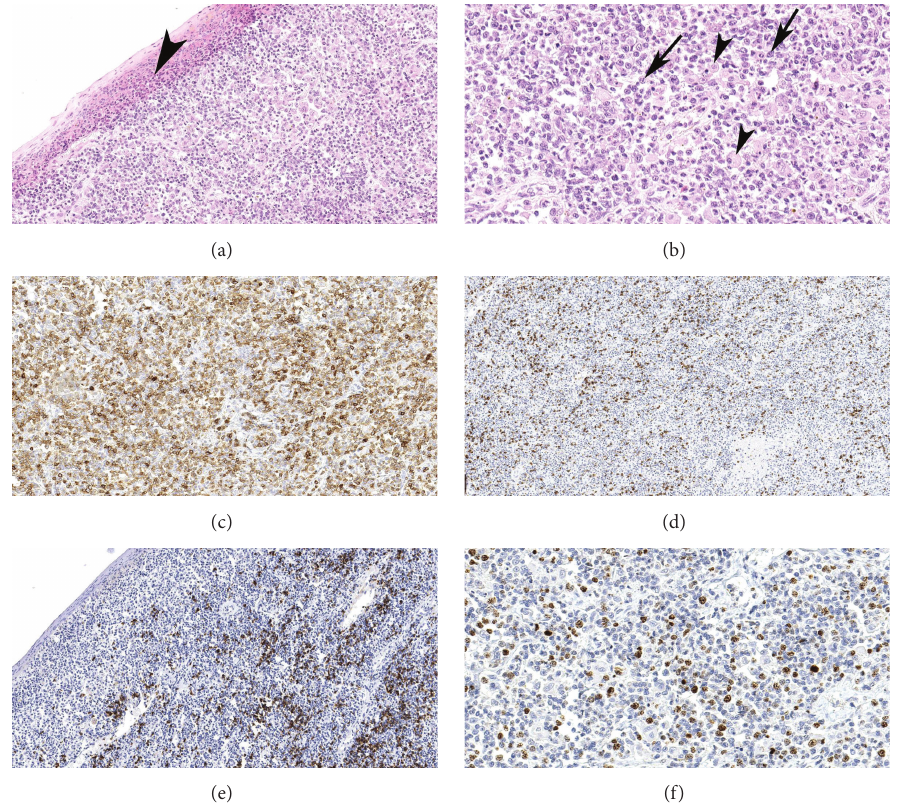
Figure 2: Histopathological analysis of the biopsy. (a) The conjunctiva was extensively infiltrated by atypical lymphocytes with epidermotropism (arrowhead; Hematoxylin and Eosin [H and E], 200x). (b) At higher magnification, the tumor showed atypical small to medium sized lymphocytes with irregular nuclei and clumped chromatin (arrow). Macrophages and reactive lymphocytes were also seen (H and E, 400x). (c) The neoplastic cells were positive for CD3 (200x). (d) Decreased coexpression by the neoplastic lymphocytes was noticed (100x). (e) CD20 was only expressed by the scattered reactive B-cells (100x). (f) Proliferative index estimated by nuclear positivity for KI-67 antigen was approximately 20%